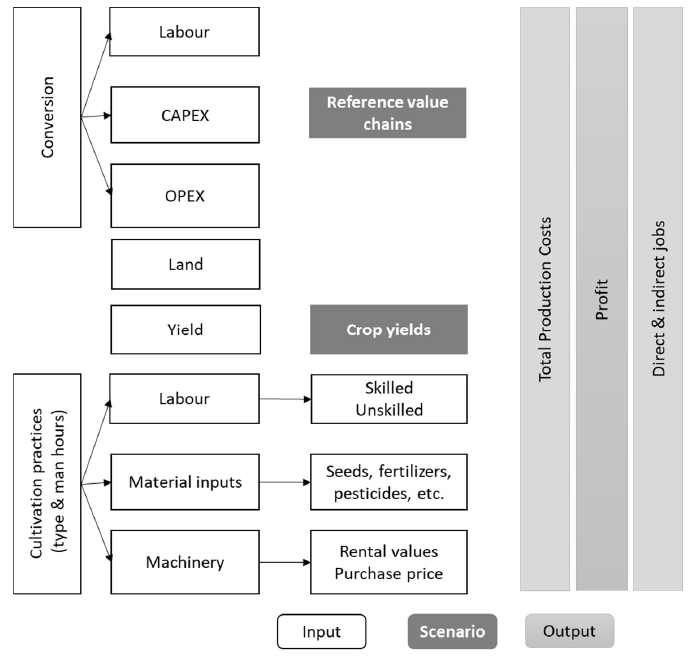
Figure 2. Model layout. 20